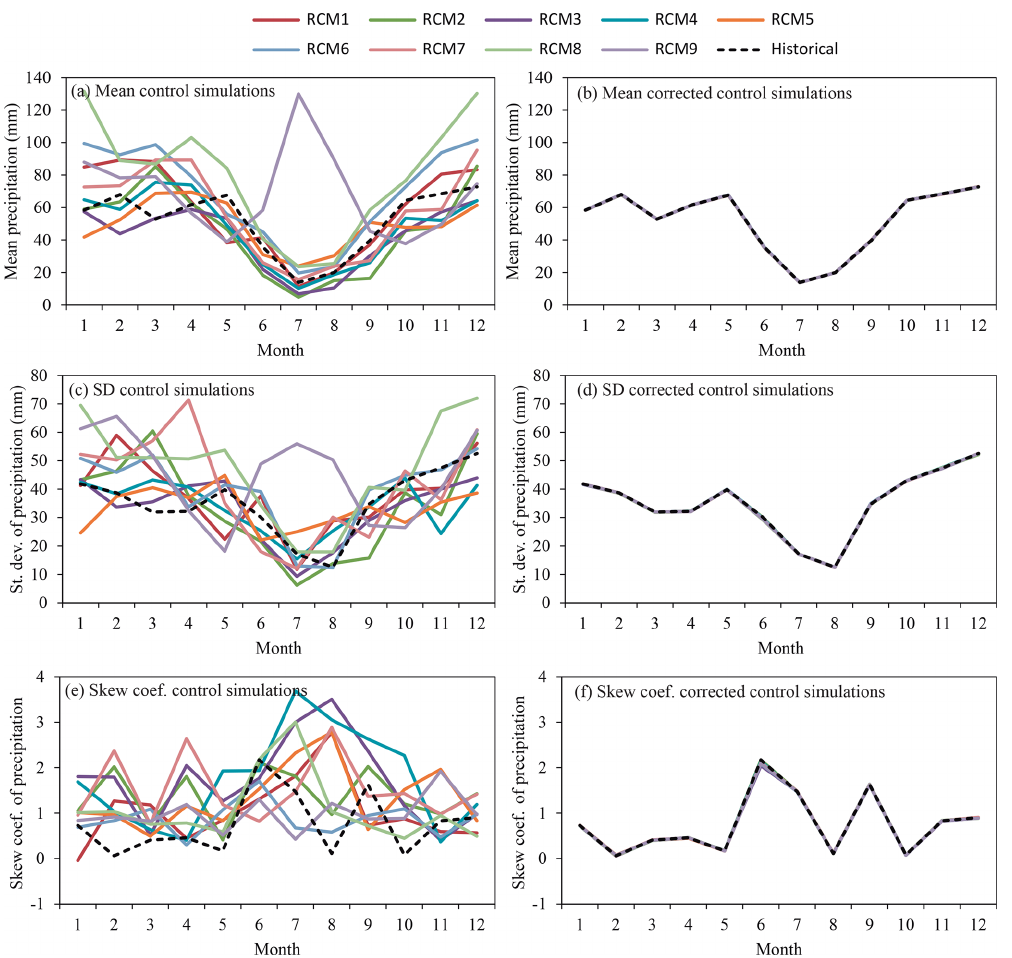
Figure 4. Monthly mean, standard deviation and skew coefficient of precipitation within the mean year of the period (1972–2001) for the historical and control simulation series (a, c, e) and historical and corrected control simulation series (b, d, f)